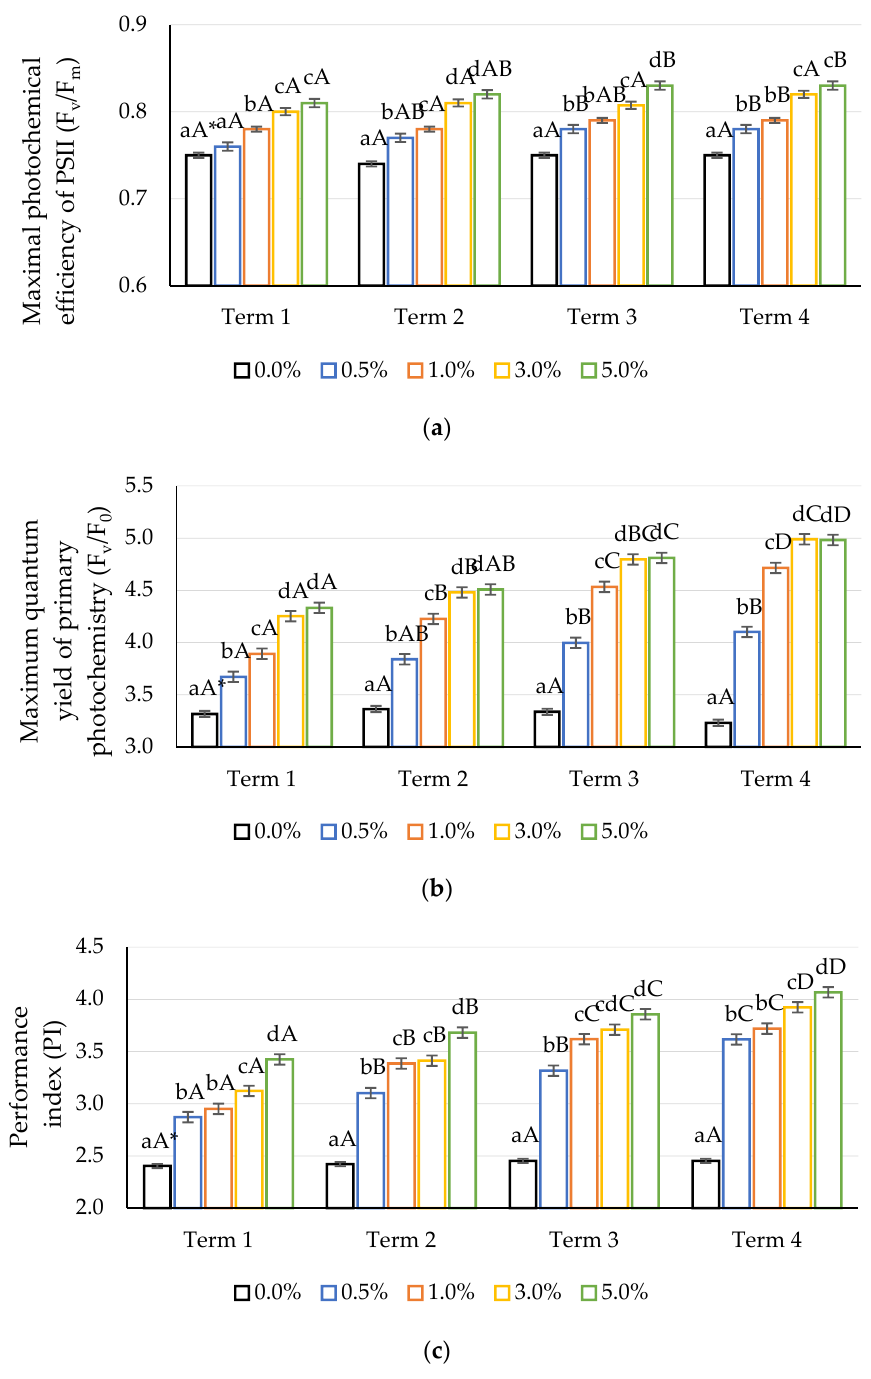
Figure 5. Impact of different aqueous concentrations of potassium quercetin derivative on Chl fluorescence parameters in the maize leaves: ( a ) F v /F m —maximal photochemical efficiency of PSII, ( b ) F v /F 0 —maximum quantum yield of primary photochemistry, ( c ) PI—performance